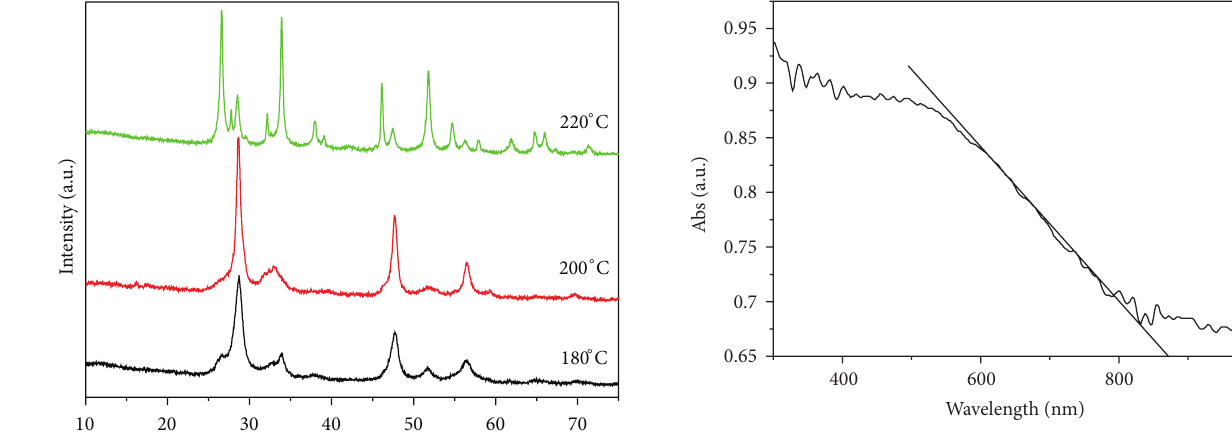
Figure 6: UV-Visible absorption spectrum of the obtained samples at 200 ∘ C for